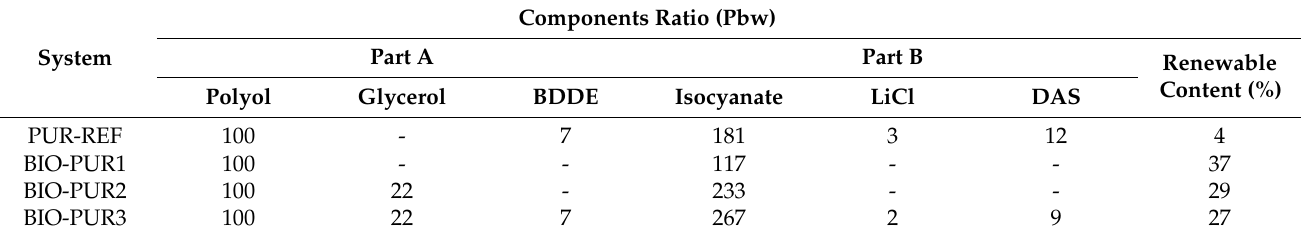
Table 1. Composition of PUR systems